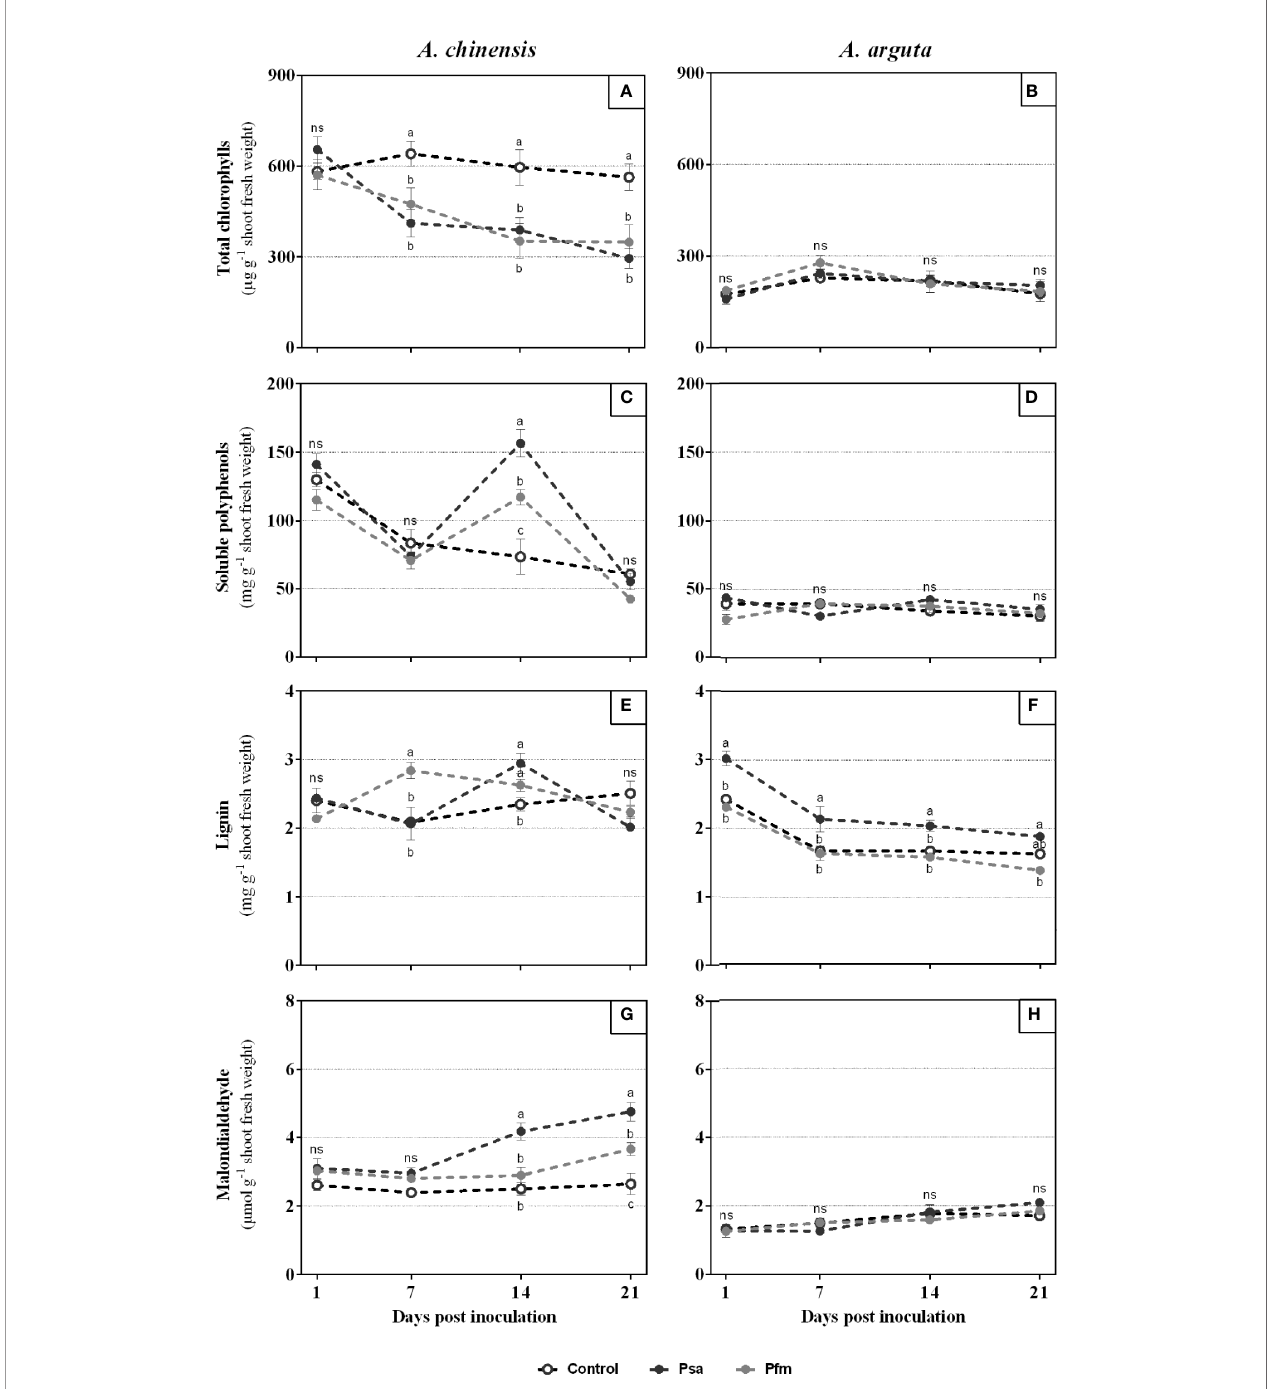
FIGURE 3 | Total chlorophylls (A, B) , soluble polyphenols (C, D) , lignin (E, F) and malondialdehyde (G, H) concentrations in Actinidia chinensis var. deliciosa cv. ‘ Hayward ’ and A. arguta var. arguta cv. ‘ Weiki ’ plants inoculated with Pseudomonas syringae pv. actinidiae (Psa) or P. syringae pv. actinidifoliorum (Pfm) registered 1, 7, 14 and 21 days post inoculation (dpi). Symbols represent the mean of three independent replicates (consisting in the pool of three plants each) ± standard error. Within each time-point, symbols with different letters are signi fi cantly different at p < 0.05 ( “ ns ” indicates no signi fi cant